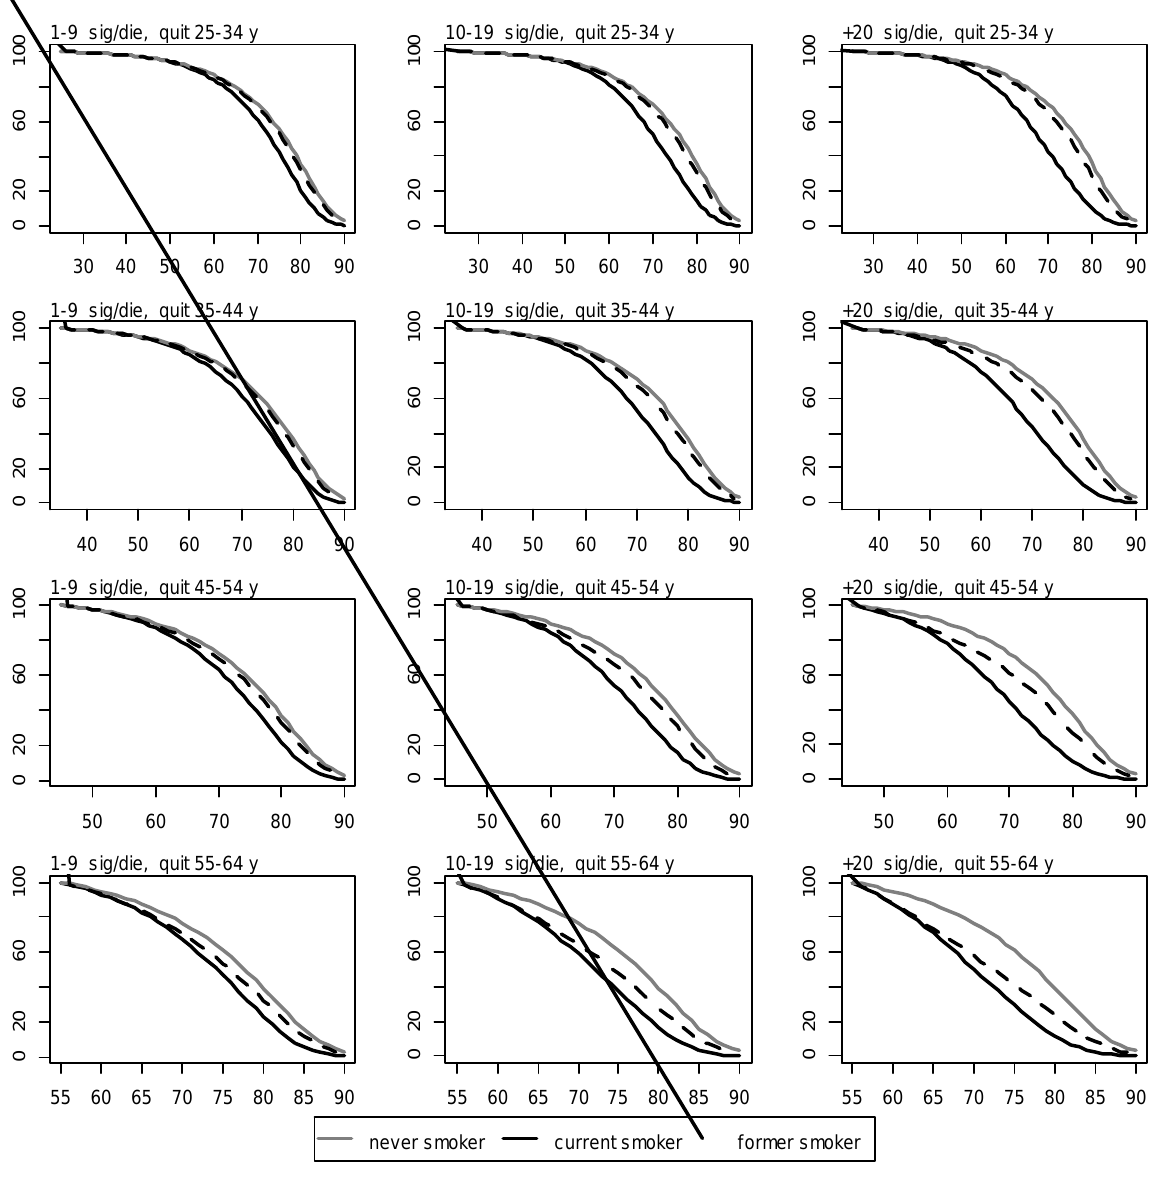
Figure 4. Survival for never, current, and former women smokers by number of